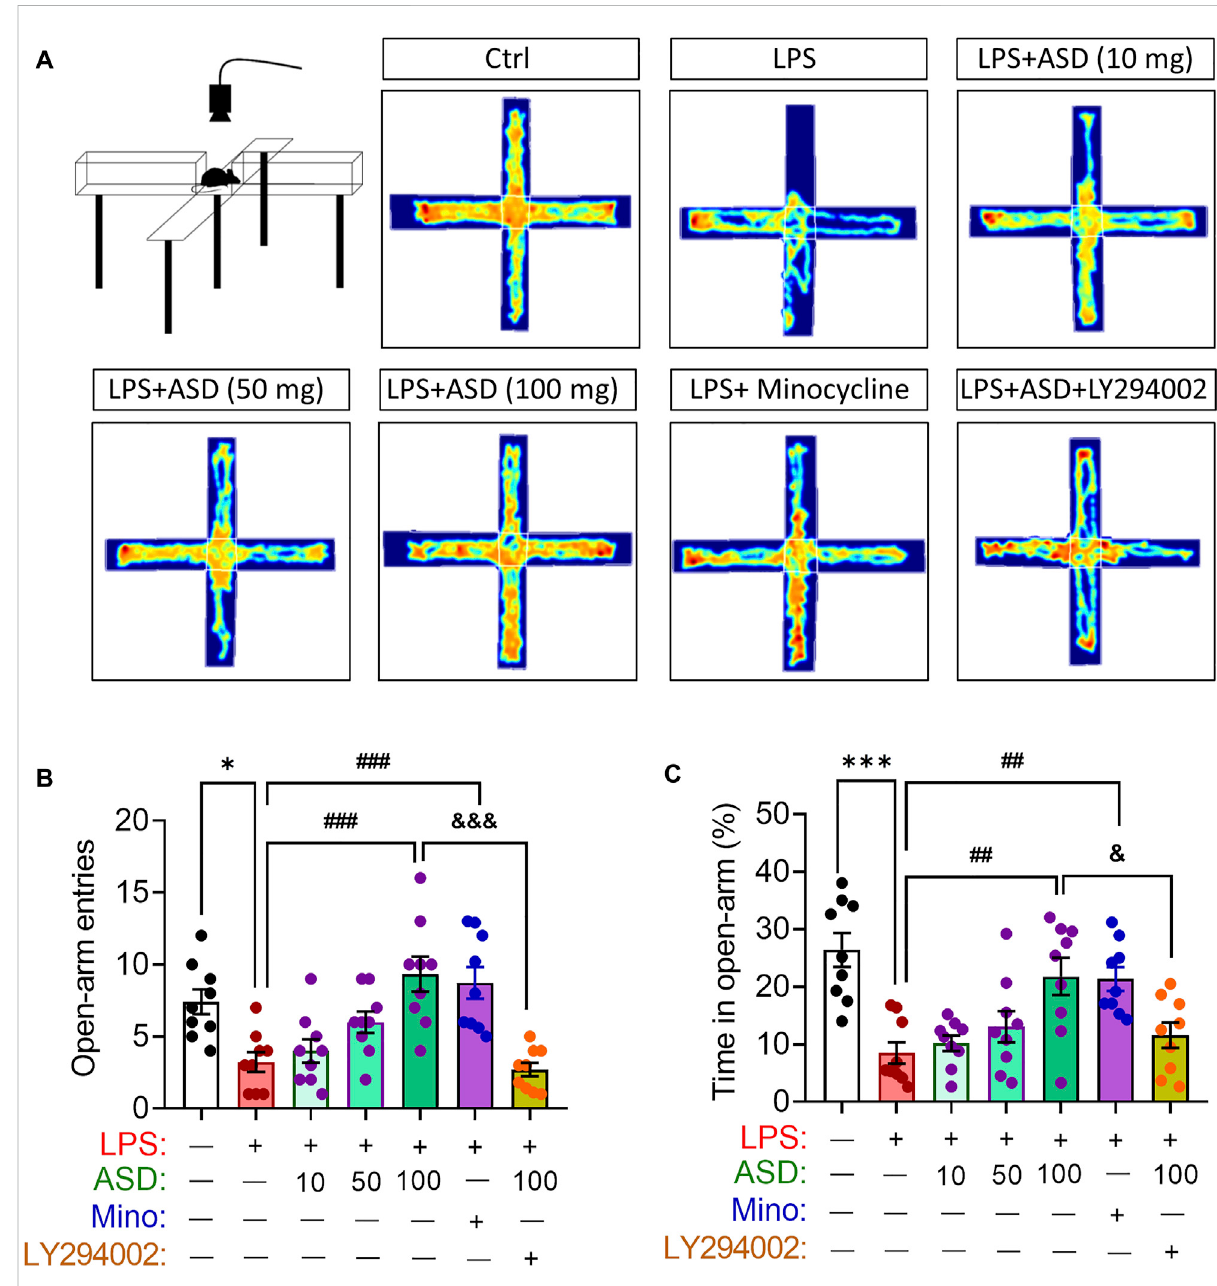
FIGURE 9 Effects of ASD on anxiety-like behaviors of mice chronically exposed to LPS in the presence or absence of PI3K-Akt inhibitor. (A) , Scheme describing the experimental evaluation of anxiety-like behaviors of mice using the elevated plus maze test, and the heatmap of mouse behavior in this test. (B,C) , Changes in open-arm entries and time in open-arms in mice treated with saline (Ctrl) or lipopolysaccharide (LPS), followed by akebia saponin D(ASD), minocycline (Mino) or PI3K-Akt inhibitor (LY294002) for 14 days. Data are mean ± standard error ofthe mean (SEM) (n =